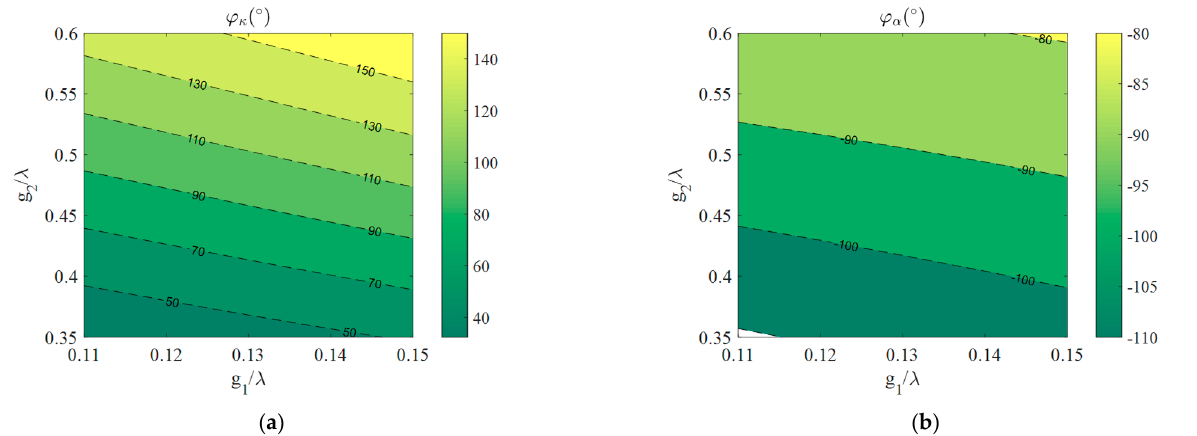
Figure A3. ( a ) Contours of ϕ k and ( b ) ϕ α as a function of g 1 and g 2 . We normalized the transduction coefficient as